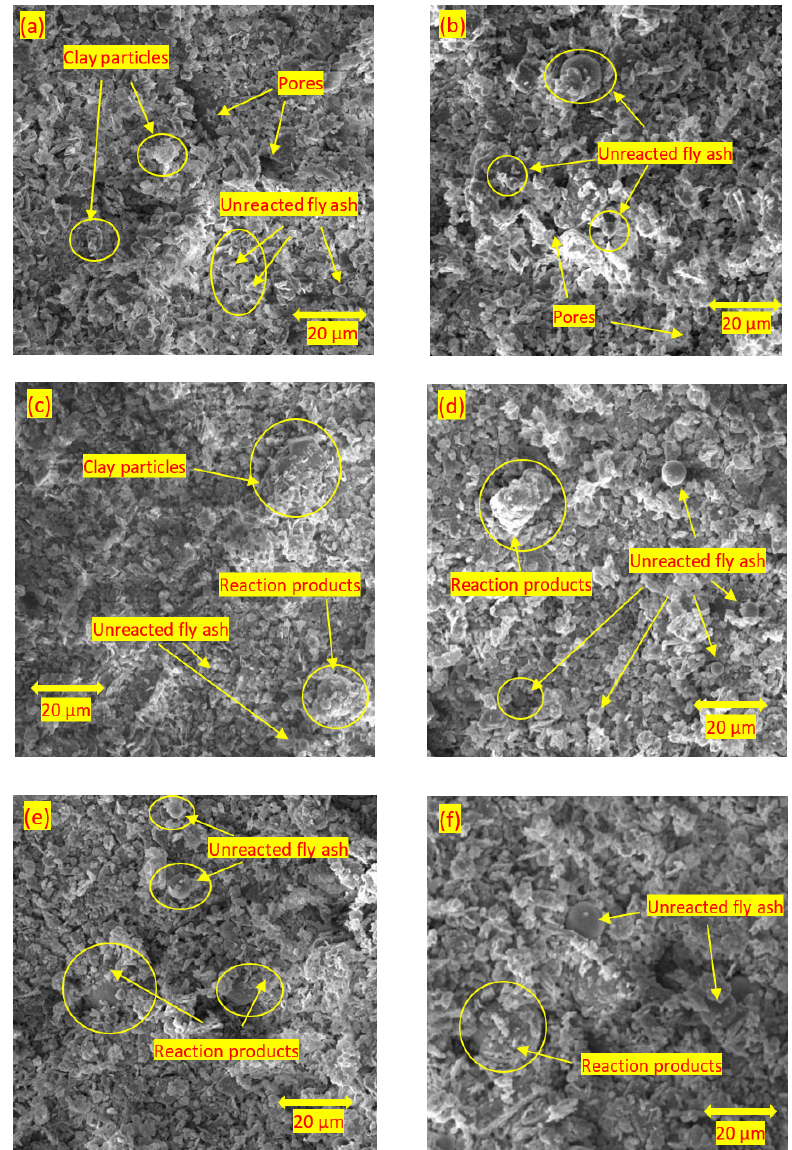
Figure 15. SEM images of soils stabilised with ( a ) 15% fly ash at 1 day of curing; ( b ) 25% fly ash at 1 day of curing; ( c ) 15% fly ash at 7 days of curing; ( d ) 25% fly ash at 7 days of curing; ( e ) 15% fly ash at 28 days of curing; and ( f ) 25% fly ash at 28 days of curing at 20 μ m.